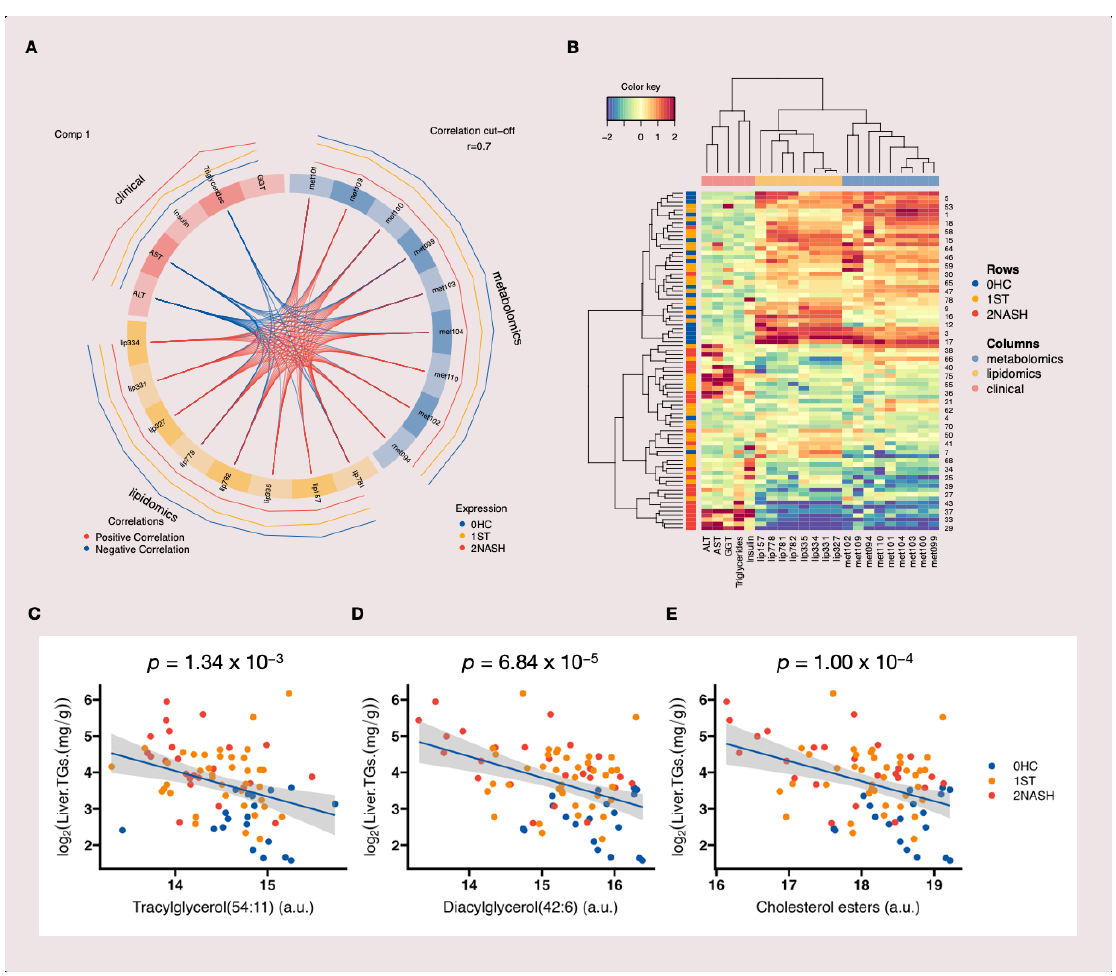
Figure 5. Our multiblock integrative analysis for clinical, metabolomic and lipidomic data: ( A ) the circos plot showing the integrative frameworks and the positive (red lines) and negative (blue lines) correlations (cutoff r = 0.7) between selected variables from each block, represented on the side quadrants (the selected feature names were coded as “metxxx” for metabolomic data and “lipxxx” for lipidomic data); ( B ) the clustered image map (CIM) for the variables selected by our multiblock sPLS-DA of the first component in which the Euclidean distance and complete linkage methods were used (the CIM shows the samples in the rows (as indicated by their stages of MAFLD on the left-hand side of the plot) and the selected features in the columns (as indicated by their data type at the top of the plot); ( C – E ) the three main lipids that matched the selected features from the multiblock analysis and correlation with liver TG content. Note: a.u., arbitrary